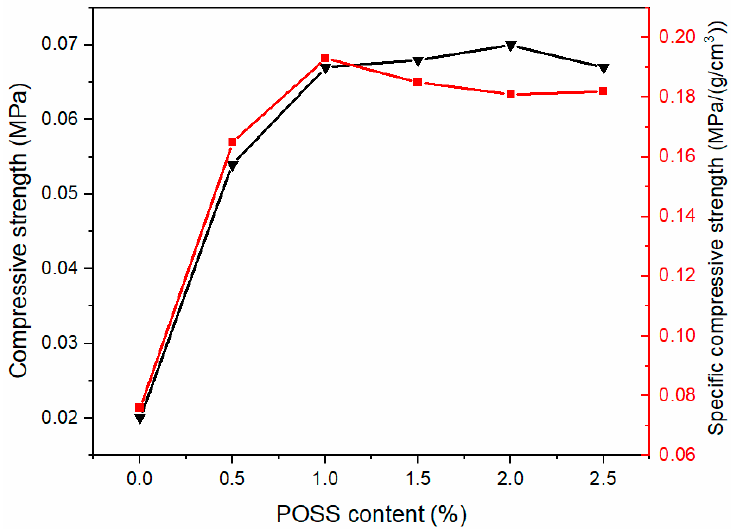
Figure 14. Mechanical strength of SIFs with different MAPOSS content.